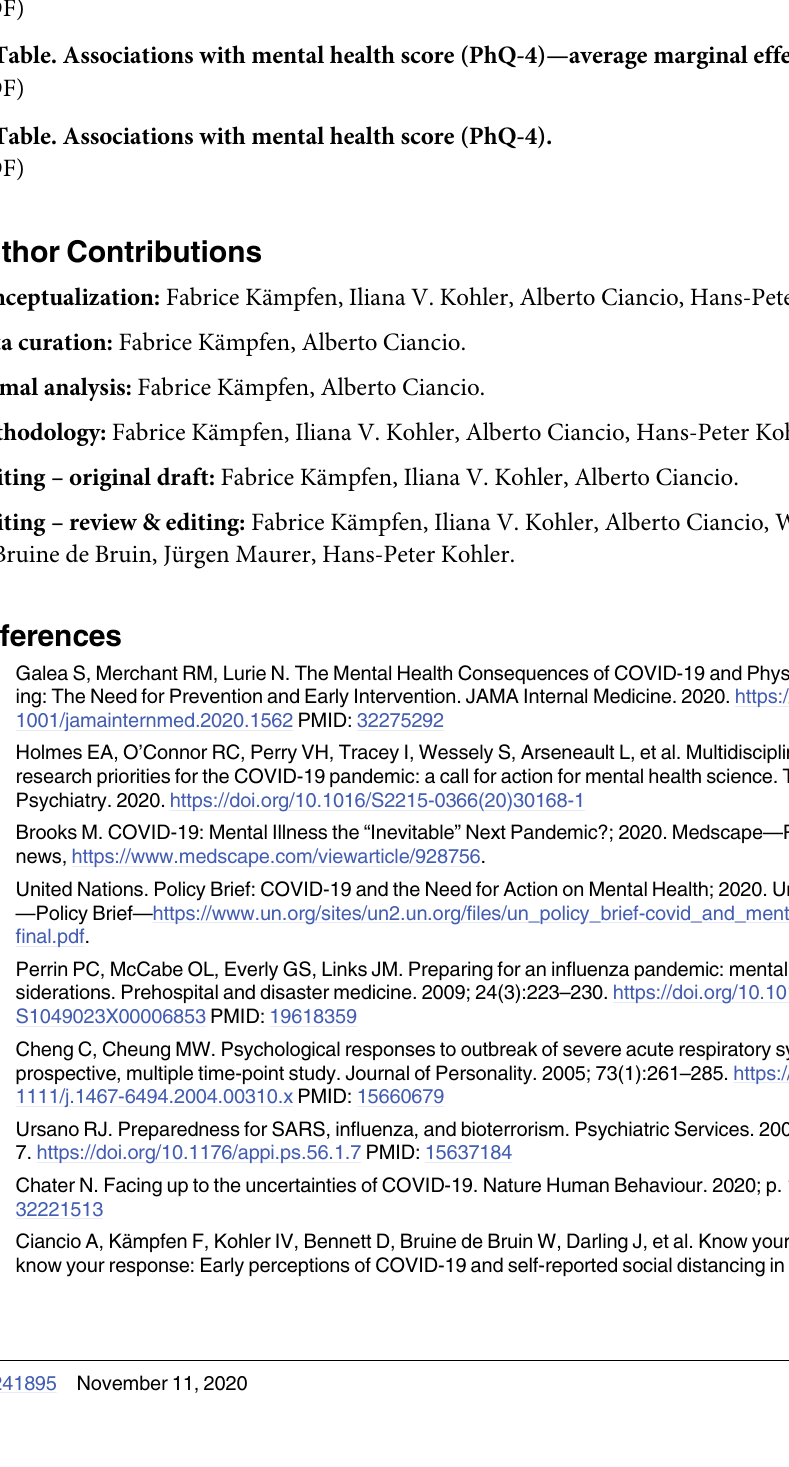
S1 Table. Descriptive statistics—additional variables. S2 Table. Differences between UAS responders and non-responders. S3 Table. Associations with Covid-19 cases and related number of deaths and mental health score (PhQ-4)—average marginal effects. S4 Table. Associations with mental health score (PhQ-4)—average marginal effects. S5 Table. Associations with mental health score